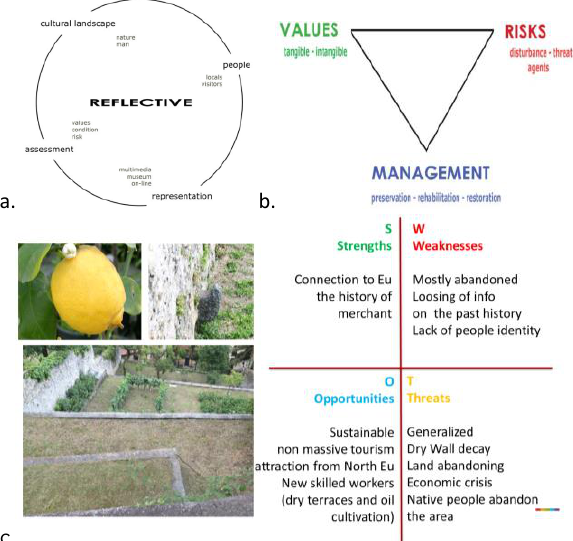
Figure 1. The Reflective approach for cultural heritage preservation and